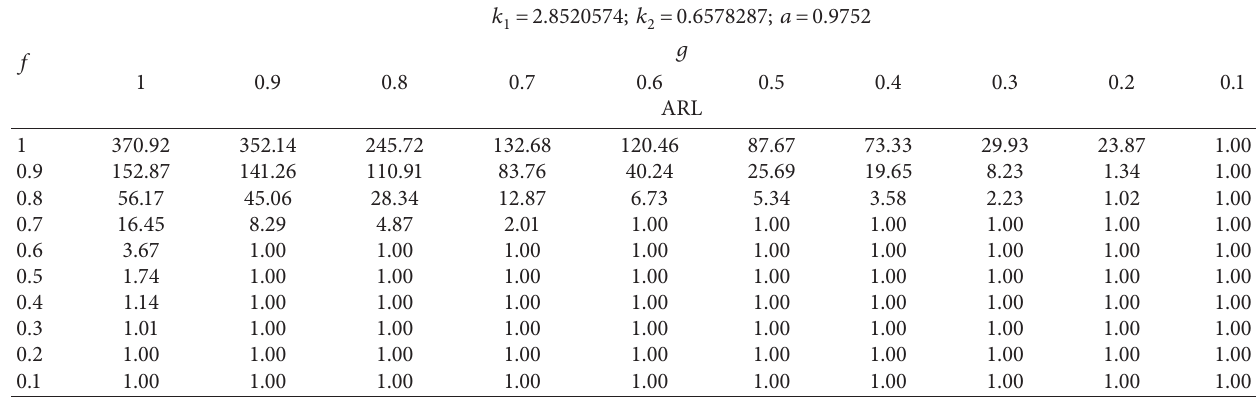
Table 5: The values of ARLs when b � 1, n � 20, and i �